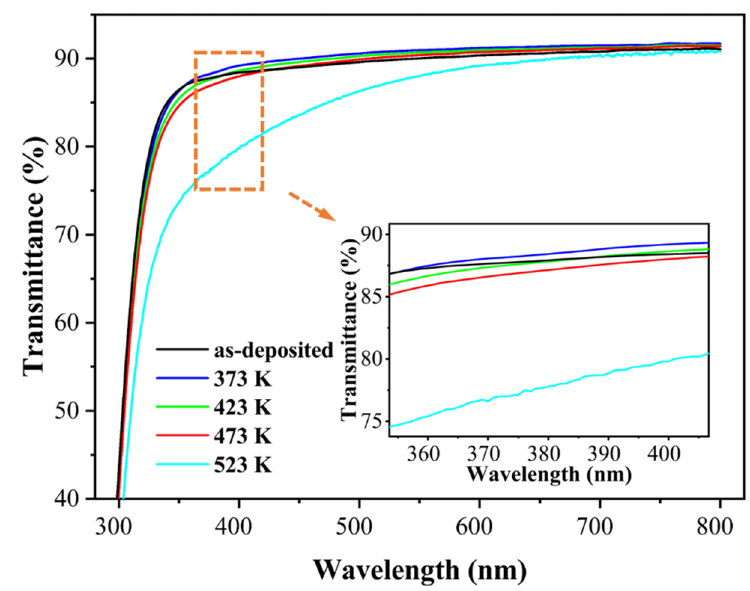
Figure 2. Transmittance curves of the films.